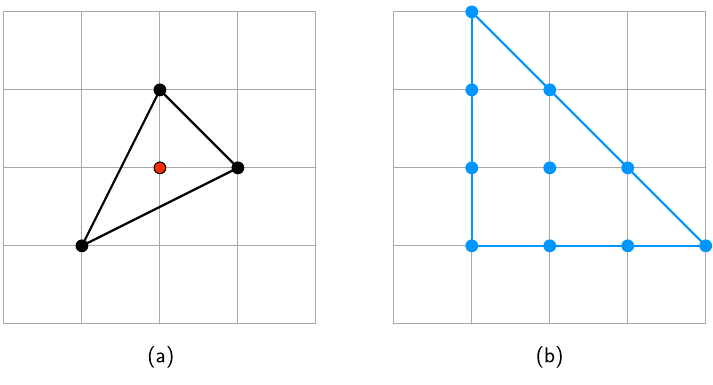
Figure 18 . (a) The toric diagram for C 3 = Z 3 and (b) the lattice of its generators. Note that the generators form the convex polygon dual to the toric